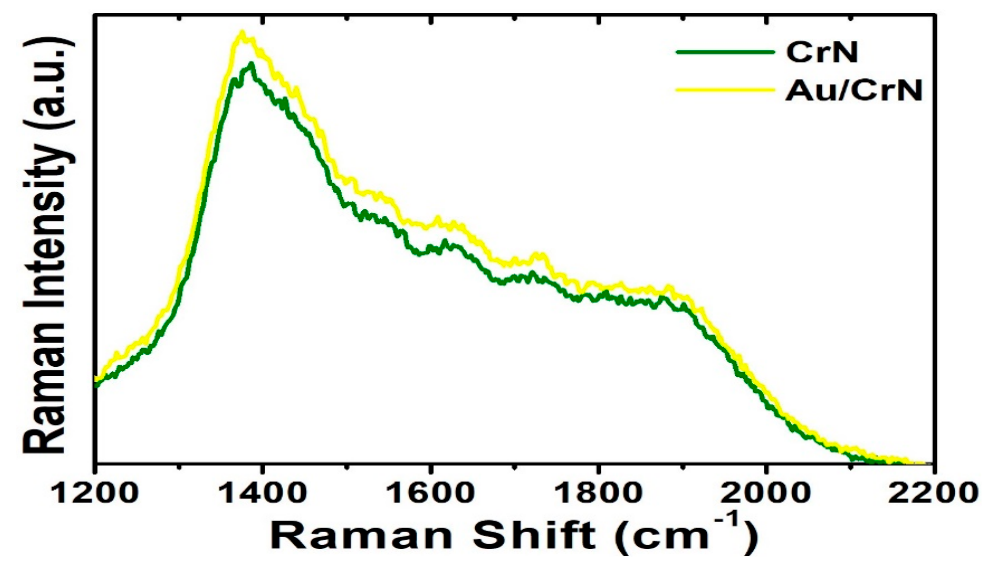
Figure 6. Raman spectra measured at room temperature for CrN films, with and without Au nanostructures, respectively.